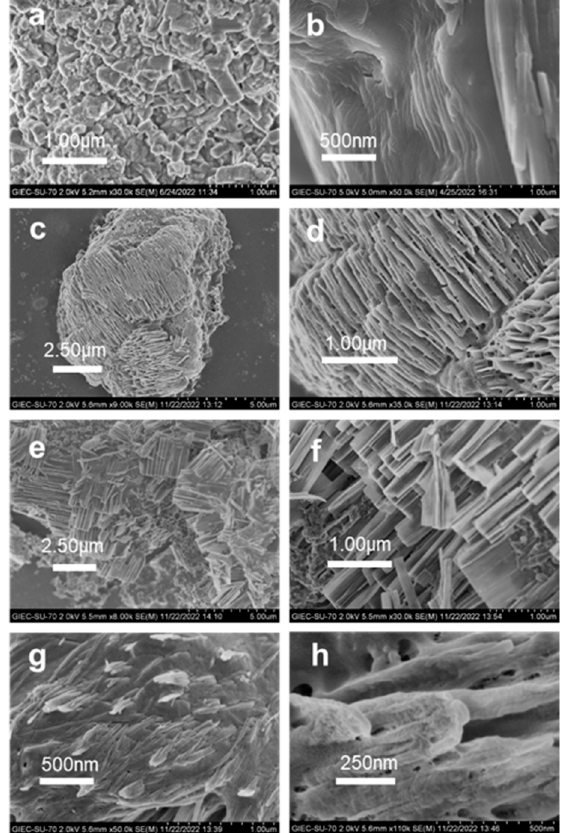
Figure 2. SEM images of the NCSO calcinated at different temperatures: ( a ) 600 °C; ( b ) 800 °C; ( c , d ) 950 °C; ( e , f ) 1050 °C; ( g , h ) NCSO reused for 12 cycles.